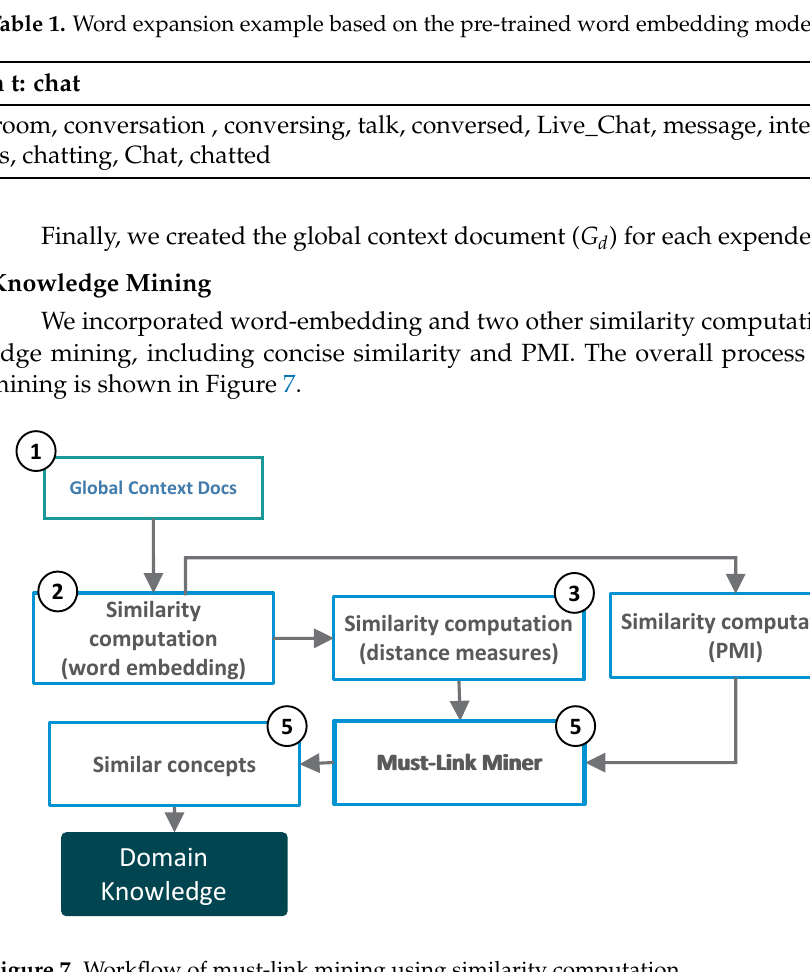
Figure 7. Workflow of must-link mining using similarity